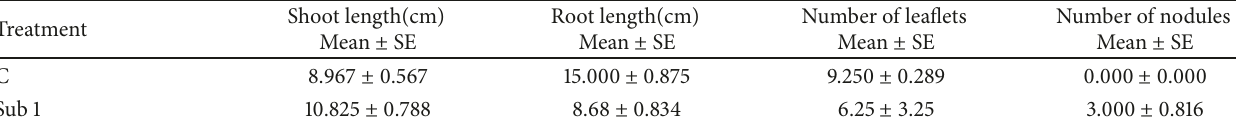
Table 4: The hydroponics experiments to assess the contribution of Sub1 to plant growth parameters.